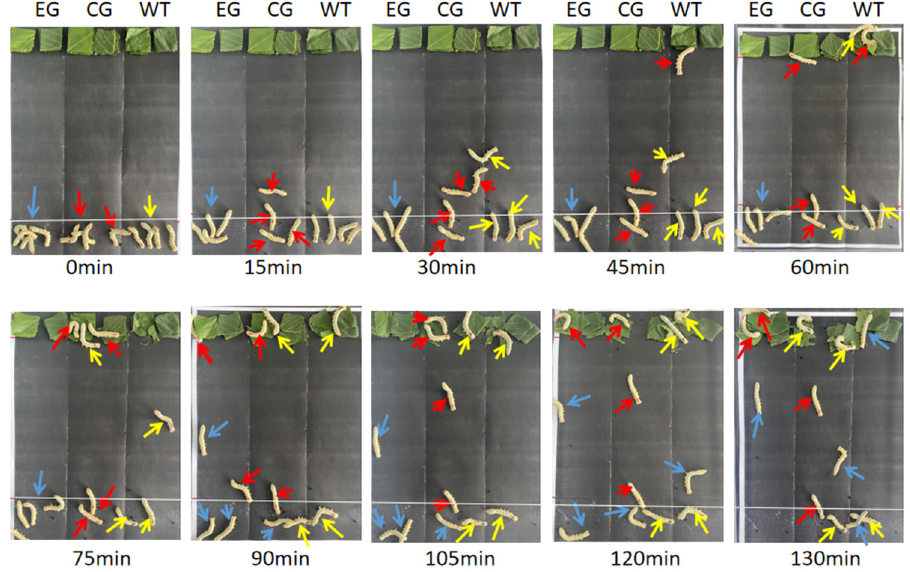
Figure 7. The crawling trajectory of Bombyx mori after 24 injections of dsRNA. EG: experimental group; CG: control group; WT: wild type. The silkworms pointed out by the blue arrows are the experimental group, the silkworms pointed out by the red arrows are the control group, and the silkworms pointed out by the yellow arrows are the wild type. The left side of each group of leaves is mulberry leaves, and the right side is gardenia leaves.